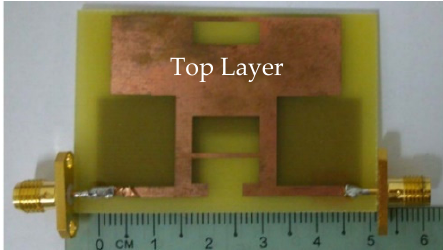
Figure 5. Fabricated prototype with T-shaped slot [60].